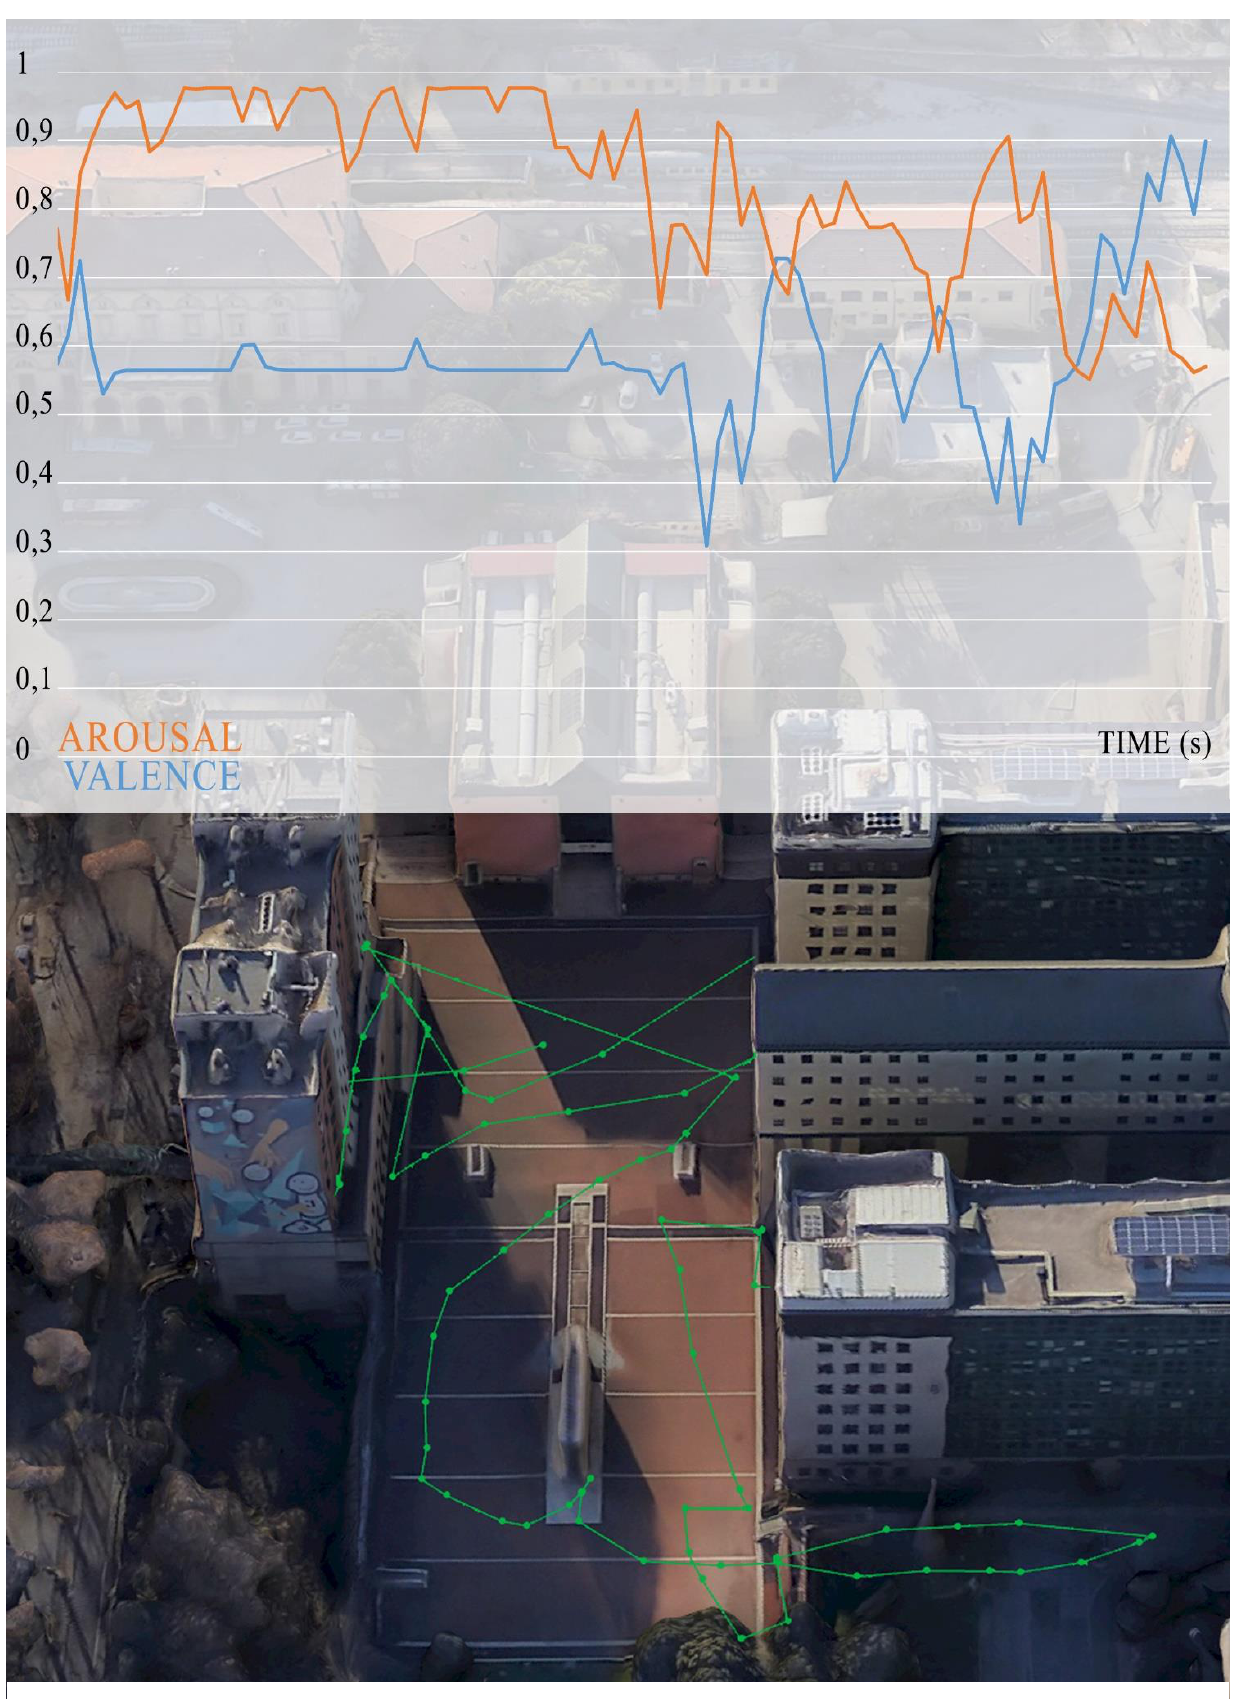
Figure 7 – Records referred to a tester concerning the Arousal and Valence values recorded in function of time and of